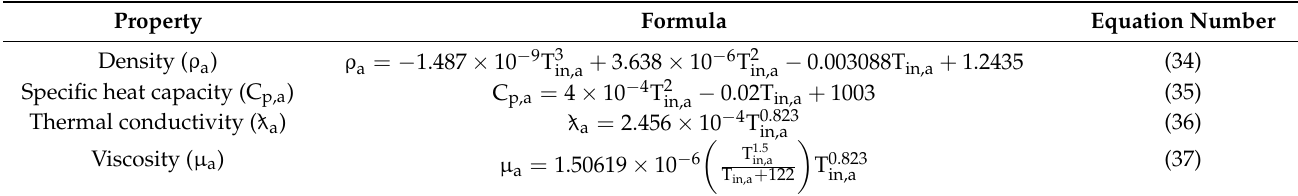
Table 2. Formulas for calculating the thermophysical properties of the